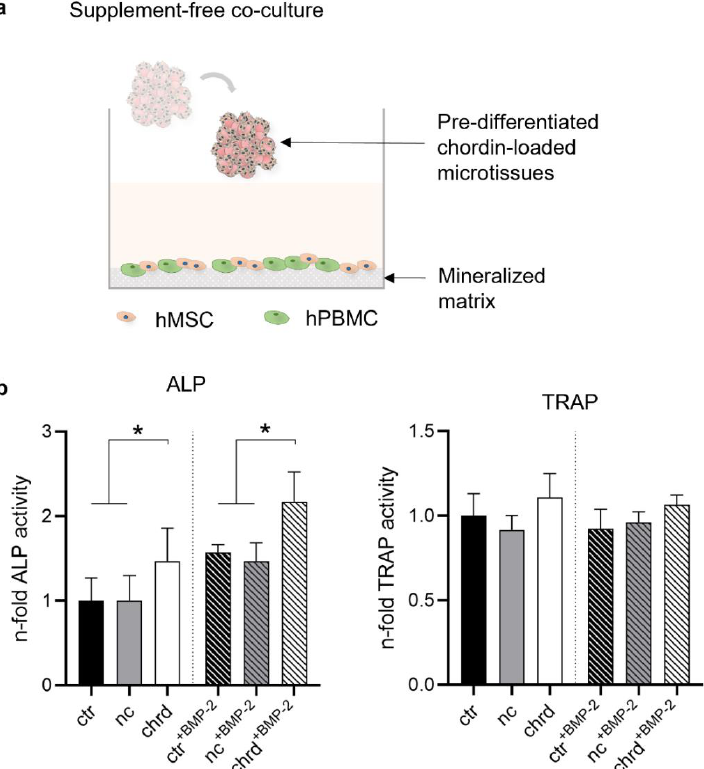
Figure 8. ( a ) Graphical outline of the experimental procedure: chordin siRNA-loaded microtissues were stimulated in OM or OM +BMP-2 for 7 days and transferred to a supplement-free co-culture system of hMSC (human mesenchymal stem cells) and hPBMC (human peripheral blood mononuclear cells) seeded on a decellularized mineralized matrix. hPBMC and hMSC were cultivated together with pre-differentiated microtissues in a supplement-free culture medium for 14 days. ( b ) ALP and TRAP activity were analyzed after 14 days of supplement-free co-culture (ctr: non-treated control, nc: non-coding siRNA, chrd: chordin siRNA). Statistically significant differences ( p < 0.05) are indicated with (*).